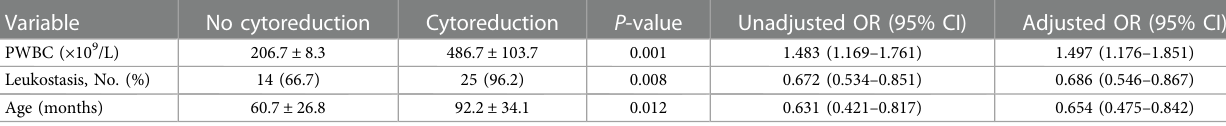
TABLE 3 Logistic regression analysis of the no cytoreduction and cytoreduction cases.